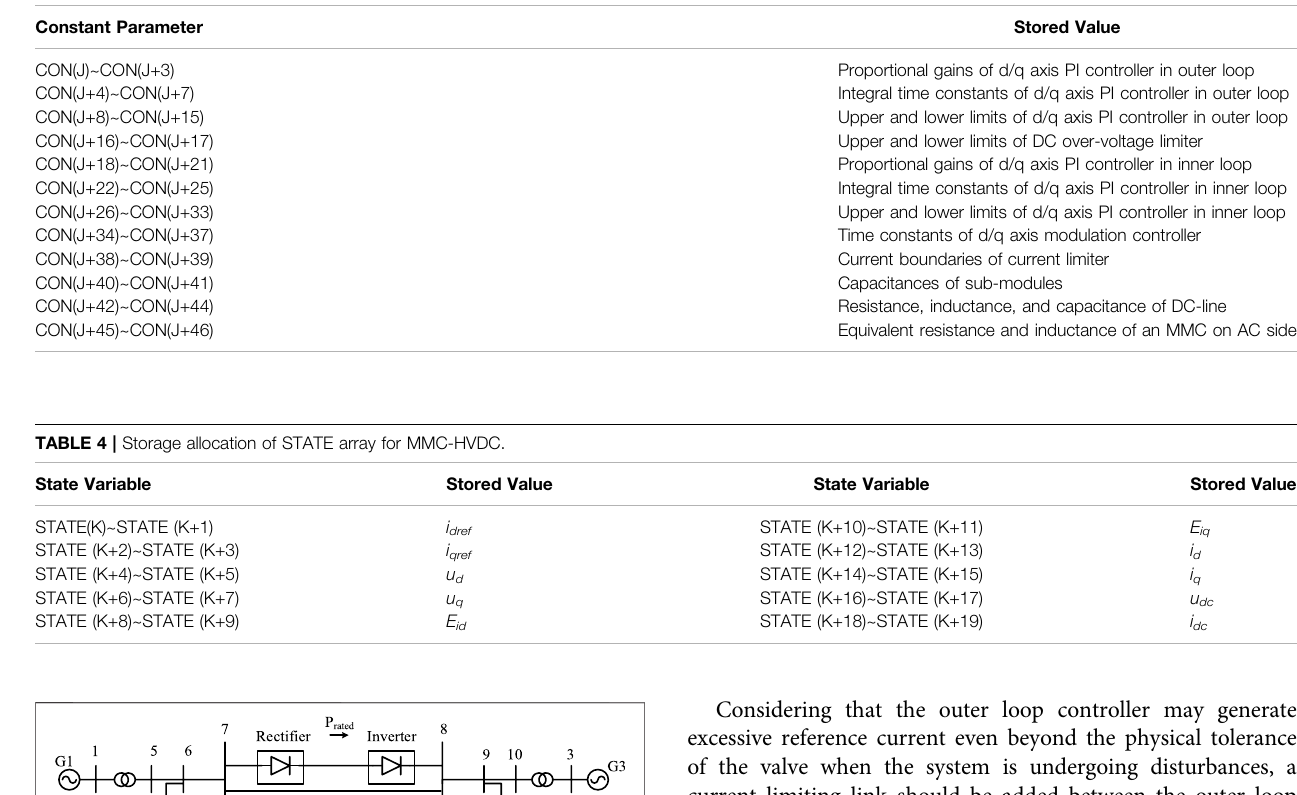
TABLE 3 | Storage allocation of CON array for MMC-HVDC.